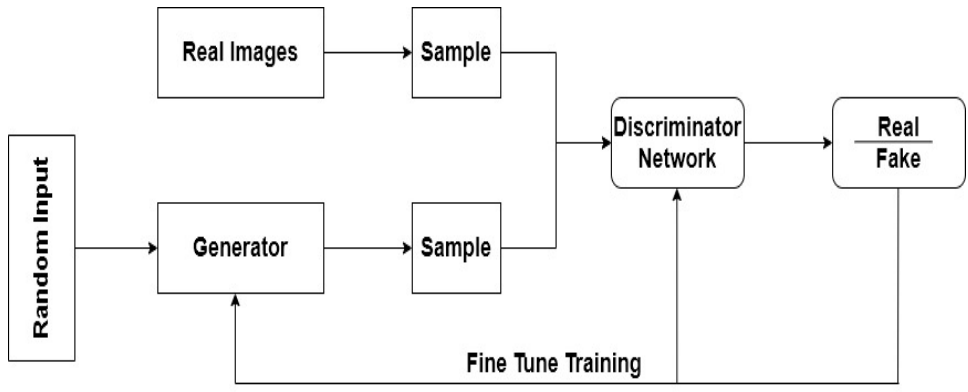
Figure 5. A representation of GAN network.